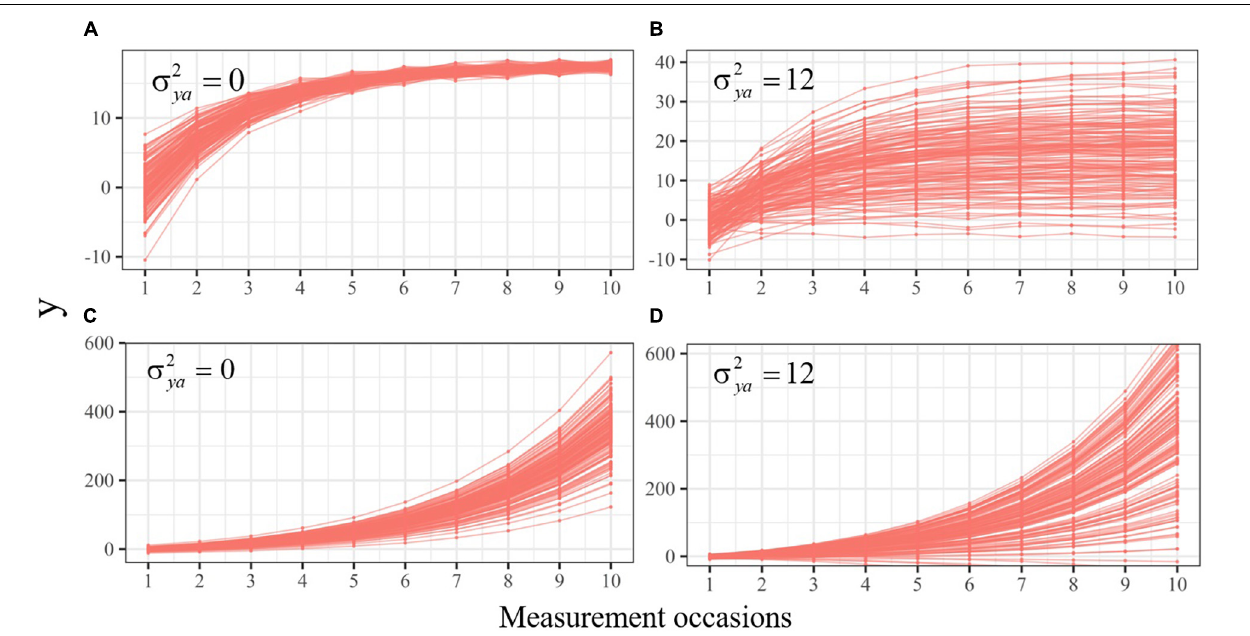
FIGURE 5 | Individual implied trajectories of decelerated (A,B) and accelerated (C,D) change with values of 0 (A,C) and 12 (B,D) for the variance of the additive components. The variance in the initial latent state is 10 across all sets, and the value of β is constant between the cases in each set.